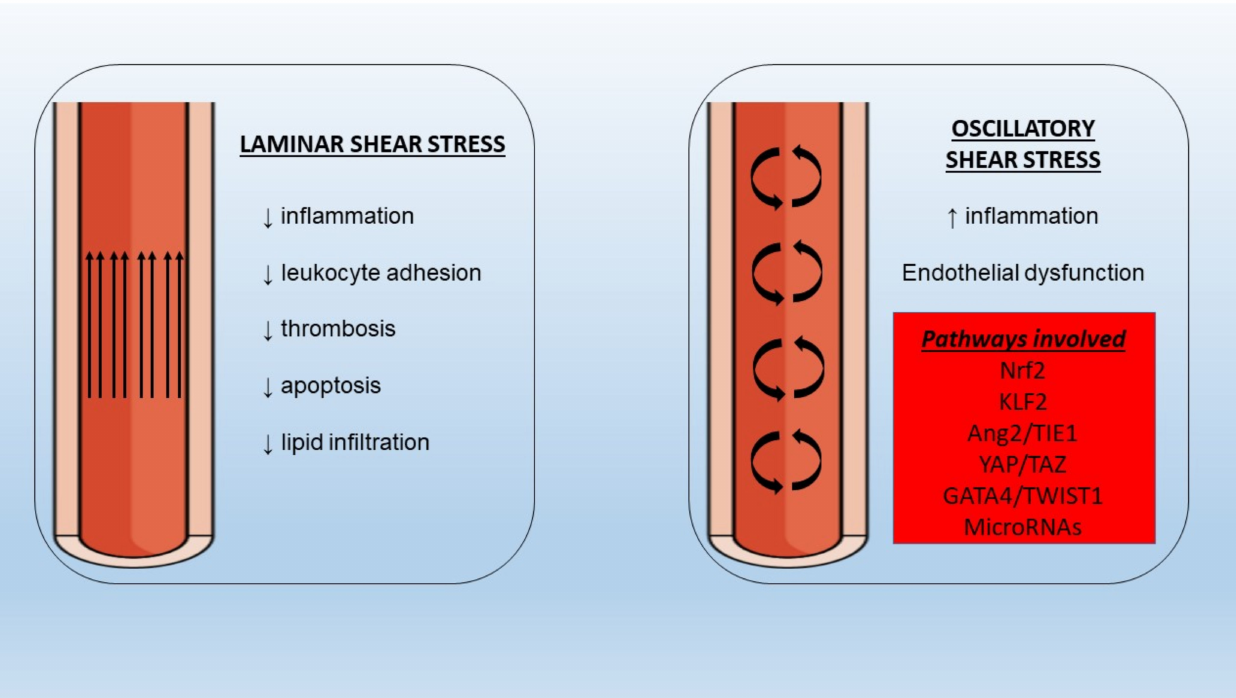
Figure 2. Different properties of laminar and oscillatory shear stress under normal and pathologic conditions with implications for inflammation and endothelial dysfunction. Nrf2: nuclear factor erythroid 2–related factor 2, KLF2: Krüppel-like factor-2, Ang2: angiopoietin-2, TIE1: tyrosine kinase with immunoglobulin-like and EGF-like domains-1, YAP: yes-associated protein, TWIST1: twist-related